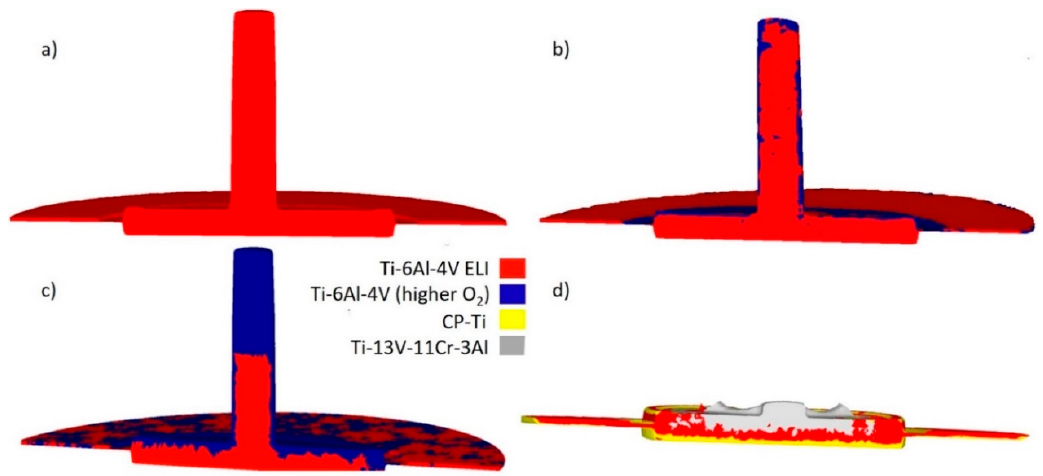
Figure 6. Isometric view of the material partitions of ( a ) Model 1, ( b ) Model 2, ( c ) Model 3, and ( d ) Model 4.